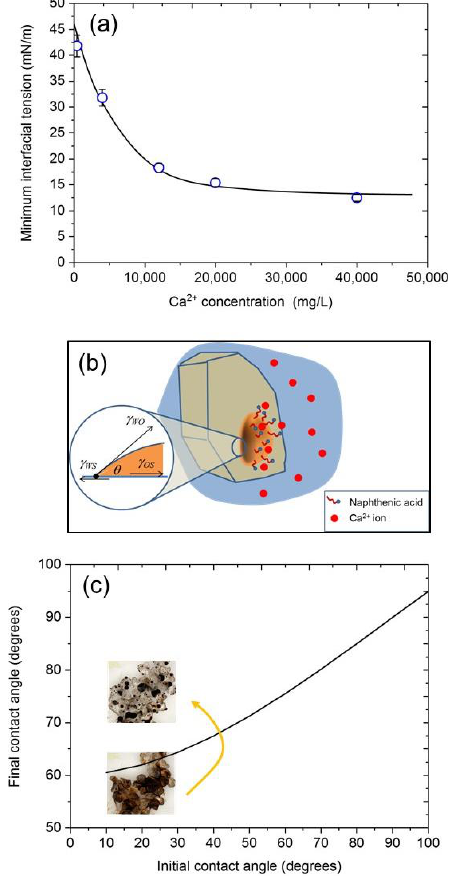
Figure 7. ( a ) The effect of Ca 2+ ion concentration (expressed here in mg/L) on the minimum interfacial tension of the n -heptane/water interface when NA is in excess. ( b ) Schematic of an oil drop adhering to a rock surface in water showing the three-phase contact point defining the contact angle. ( c ) Demonstrating the effect of a decrease in Ca 2+ concentration from 20,000 mg/L to 5000 mg/L on the final contact angle for different initial contact angles, and a simulated visual result on a sand surface to illustrate.